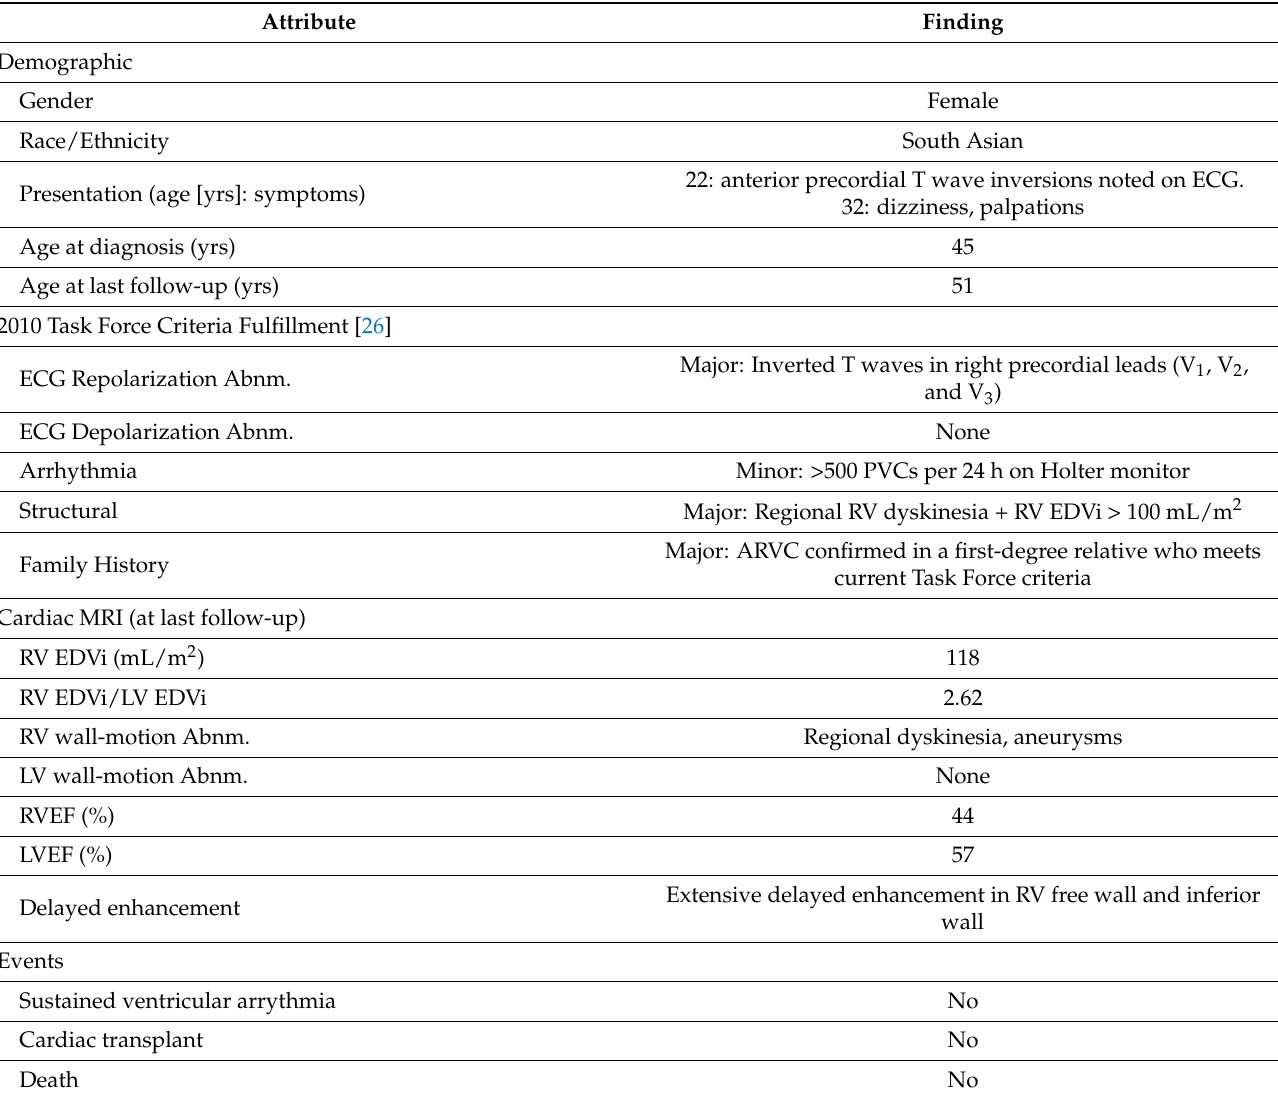
Table 1. Demographic data and clinical history of patient JHU013. 2010 Task Force Criteria were